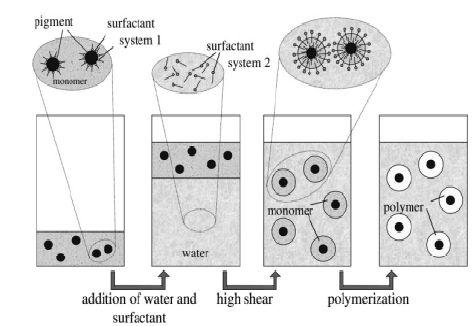
Fig. 4. Encapsulation of pigment by miniemulsion